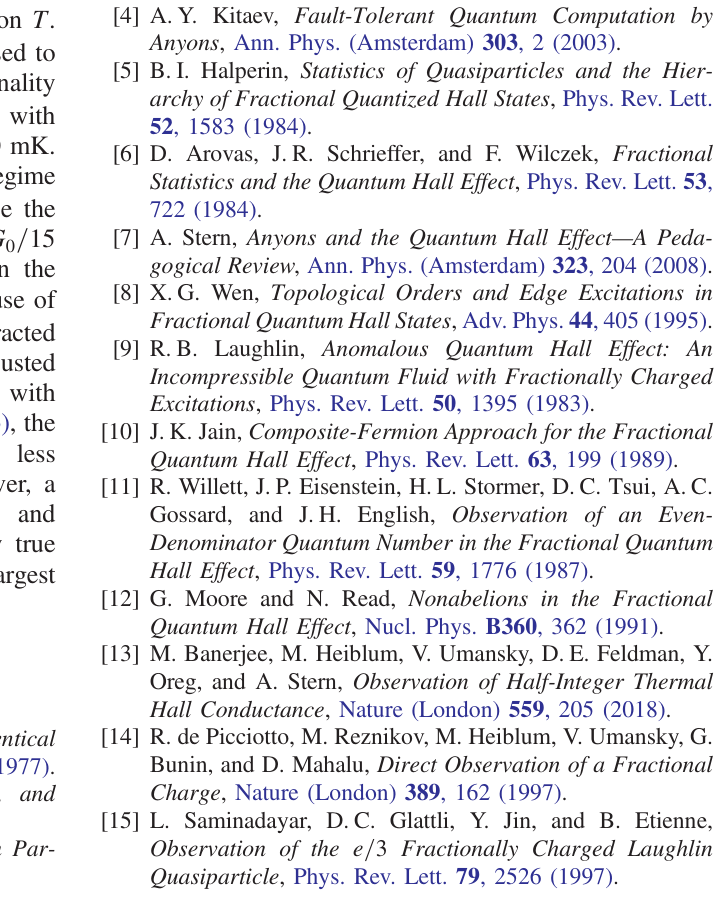
˜ T (1997).FIG. 6. versus T and analysis of S = ½ 2 e (cid:2) T ð 1 − T Þ(cid:4) in the balanced configuration. (b) ˜ T as a function of I 34 configuration. The blue, red, and magenta dashed lines are comparisons with Eq. (4), adding an offset is adjusted for the best agreement between data and